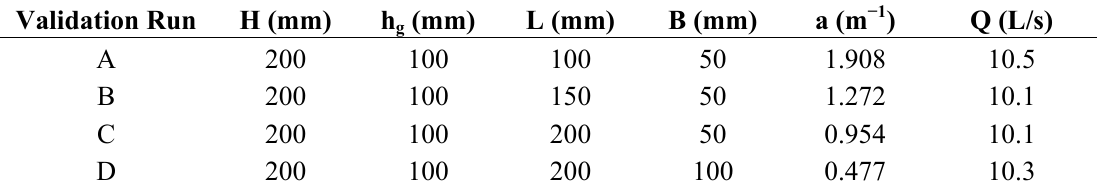
Table 1. Summary of flume experiments selected from Plew [15] for kelp-type module validation. a is the projected cylinder flow-facing area per unit volume inside the canopy, and Q is the flow rate (data obtained from Plew